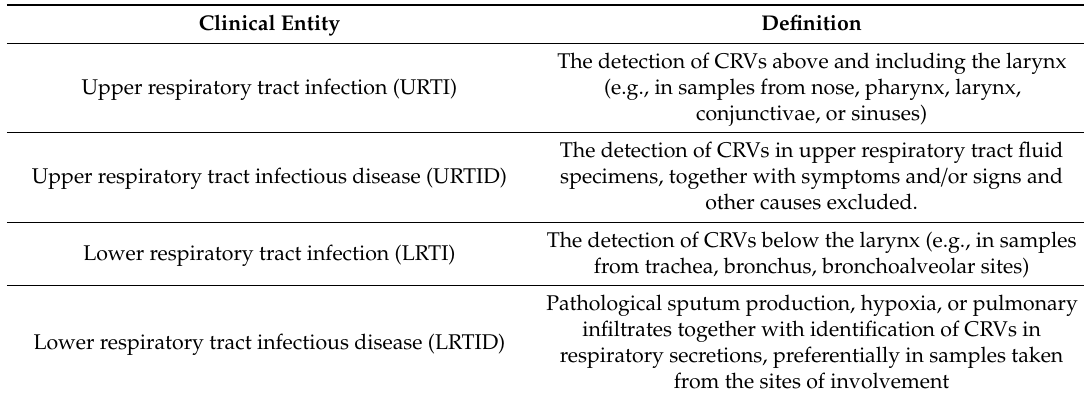
Table 2. ECIL-4 definitions of community-acquired viral respiratory tract infections